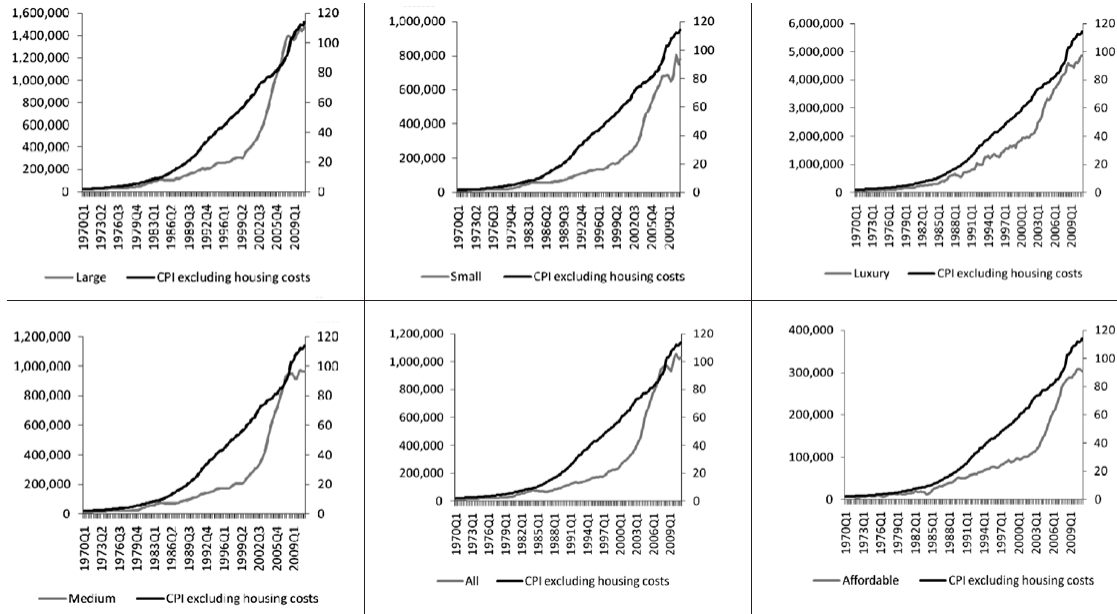
Figure 1. Relationship between house prices of different segments and CPI excluding housing